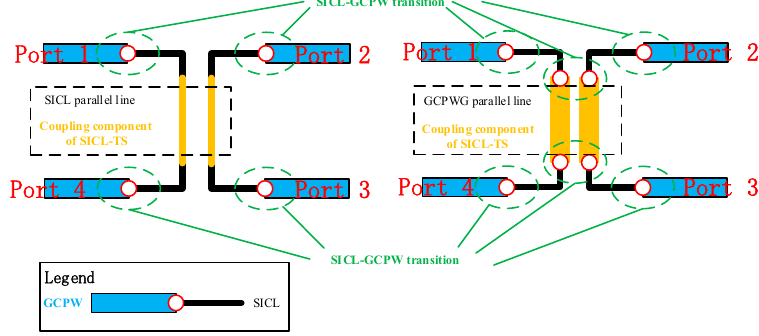
Figure 2. Illustrations of the SICL-TS and the GCPW-TS.